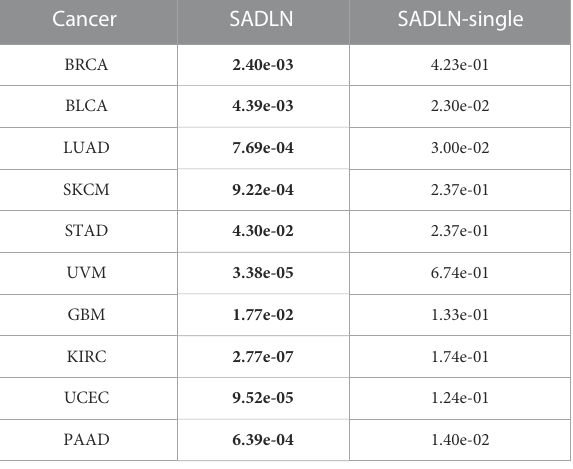
TABLE 7 The p values of survival analysis in Cox log-rank model of SADLN based multiple omics data and single omics data (bold indicates that this method performs better on the corresponding cancer dataset).